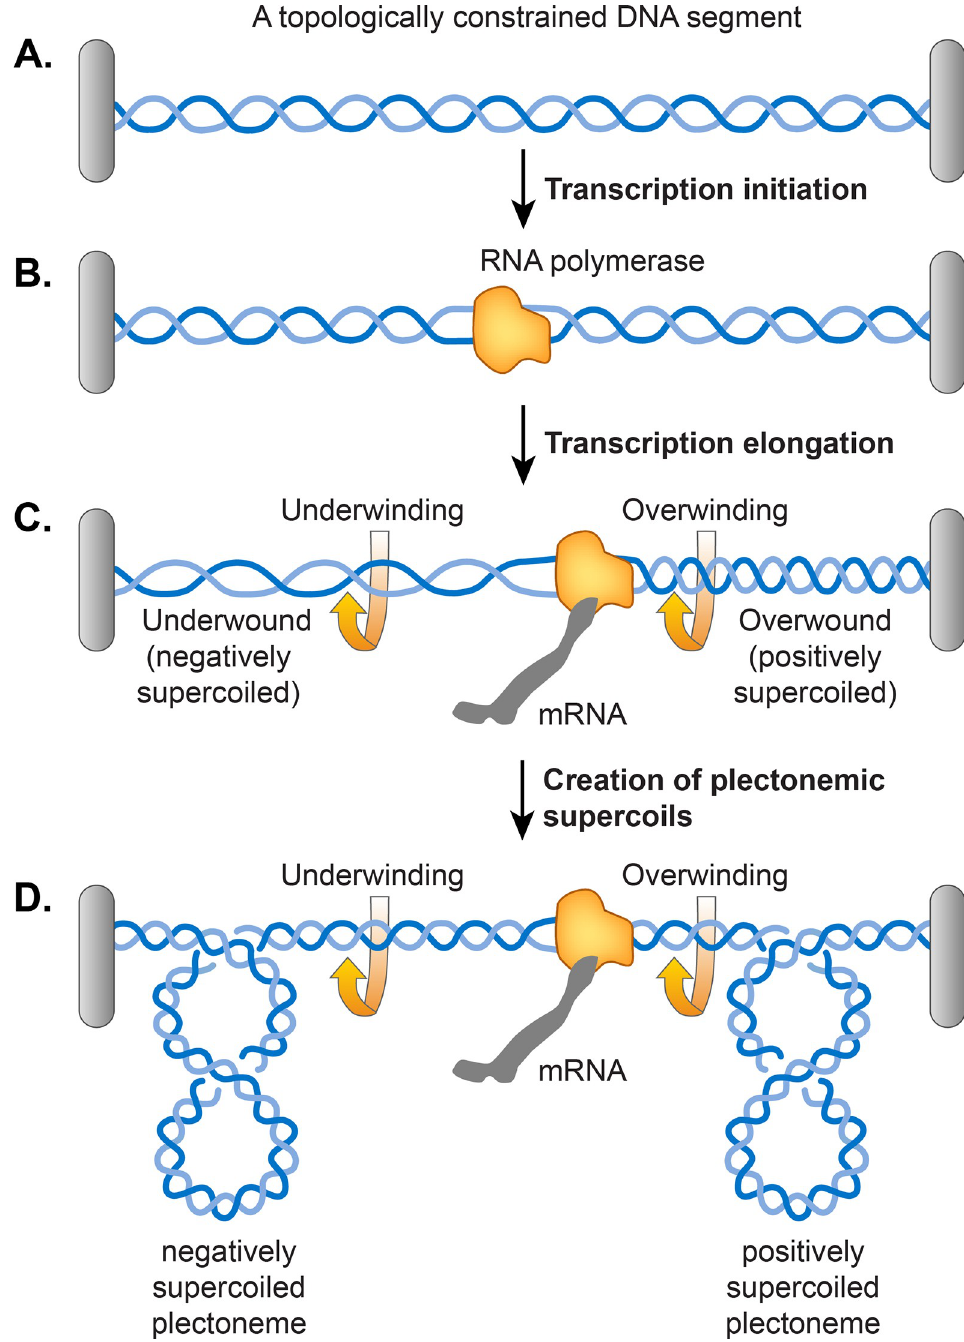
Fig 6. Twin supercoiling domain model for transcription-induced supercoiling. A. An example of topologically constrained DNA. A grey bar represents a topological constraint, e.g. a protein or a membrane anchor. B. Accommodation of RNA polymerase for transcription initiation results in the opening of the DNA double helix. C. An elongating RNA polymerase complex cannot rotate around the helical axis of DNA. Therefore, removal of helical turns by RNA polymerase causes overwinding of the topologically constrained DNA ahead and underwinding of the DNA behind, generating positively and negatively supercoiled DNA, respectively. Supercoiling can manifest as either change in the numbers of twists as shown in C or plectonemic writhe as shown in D